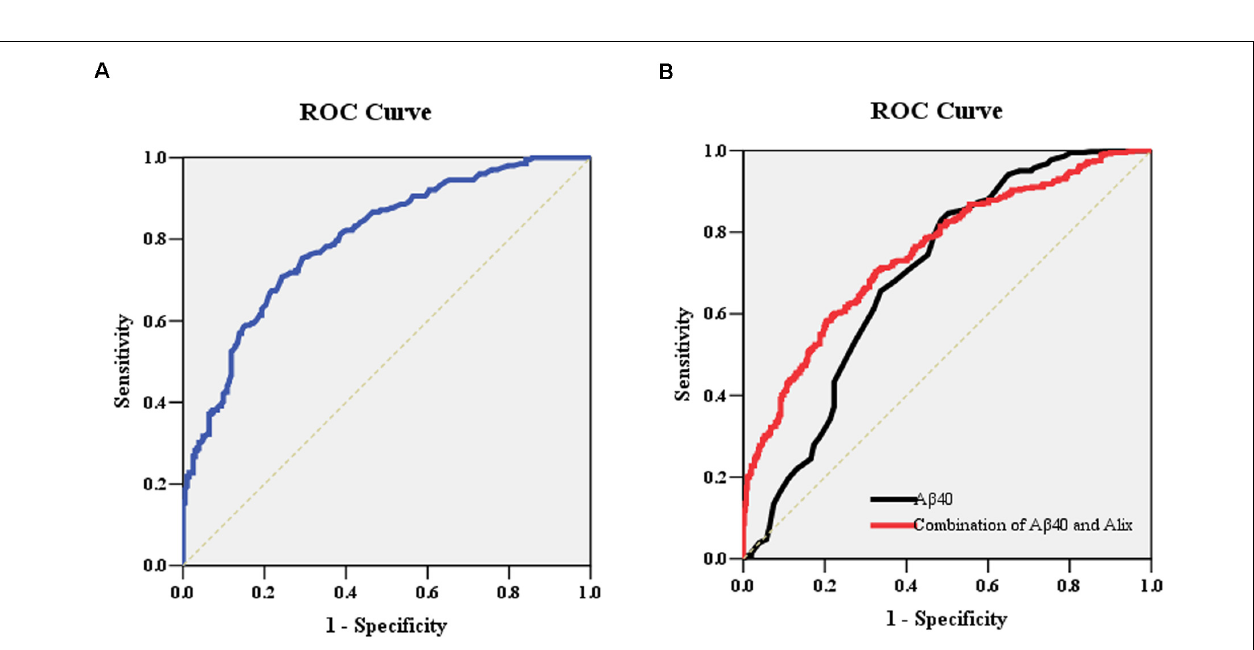
FIGURE 4 | (A) ROC curve analysis for serum Alix concentration and the prediction of the presence of AD. The AUC was 0.80. The optimal cut-off value (199.5 pg/ml) was selected. The diagnostic accuracy for Aix protein levels was 74% with the sensitivity and specificity 76% and 71%, respectively. (B) ROC curve analysis for the combination of serum A β 40 and Alix. The AUC value of A β 40 was 0.69, and the AUC for the combined detection of A β 40 and Alix was raised to 0.75. Abbreviations: ROC, receiver operating characteristic; AUC, area under the